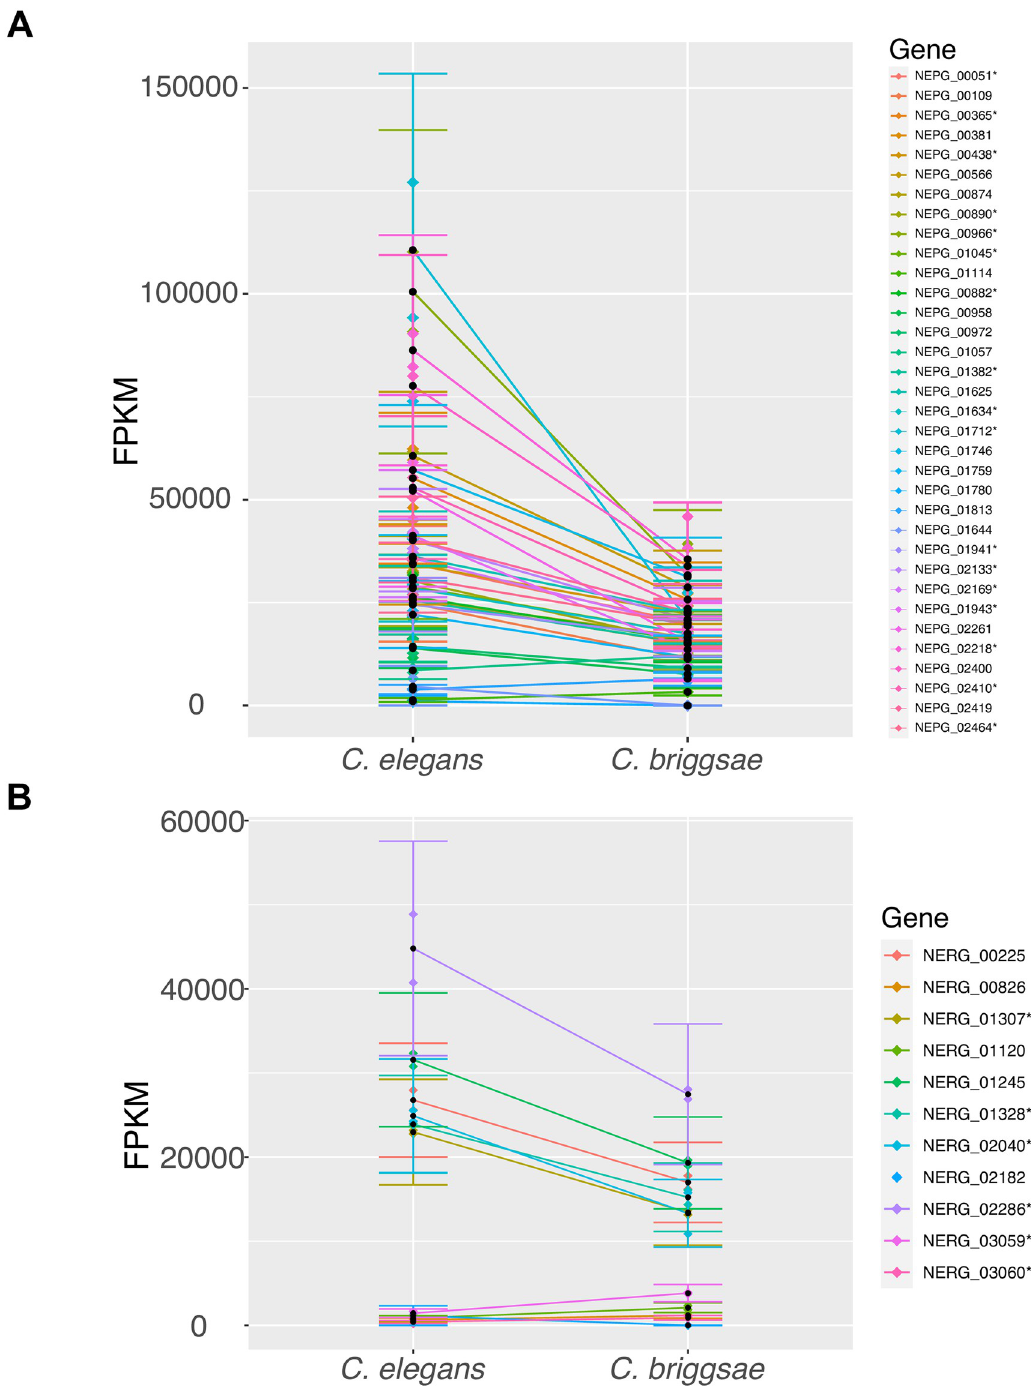
Fig 4. Differentially regulated genes of Nematocida . (A-B) Line plots of the FPKM values with confidence intervals, calculated for the differentially regulated genes (FDR < 0.05) in N . parisii (A) and N . ausubeli (B) at 10 hours post infection. � indicates ribosomal protein-encoding genes. The aggregate sample value of the two replicates is noted as a black dot within the confidence interval, while the value for each replicate is shown as a dot of matching colour along the confidence interval. Error bars of each gene show the variability of the distribution of FPKM